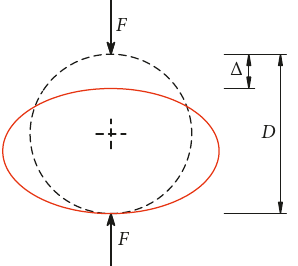
Figure 6: Deflection of the pipe subjected to the concentrated load F